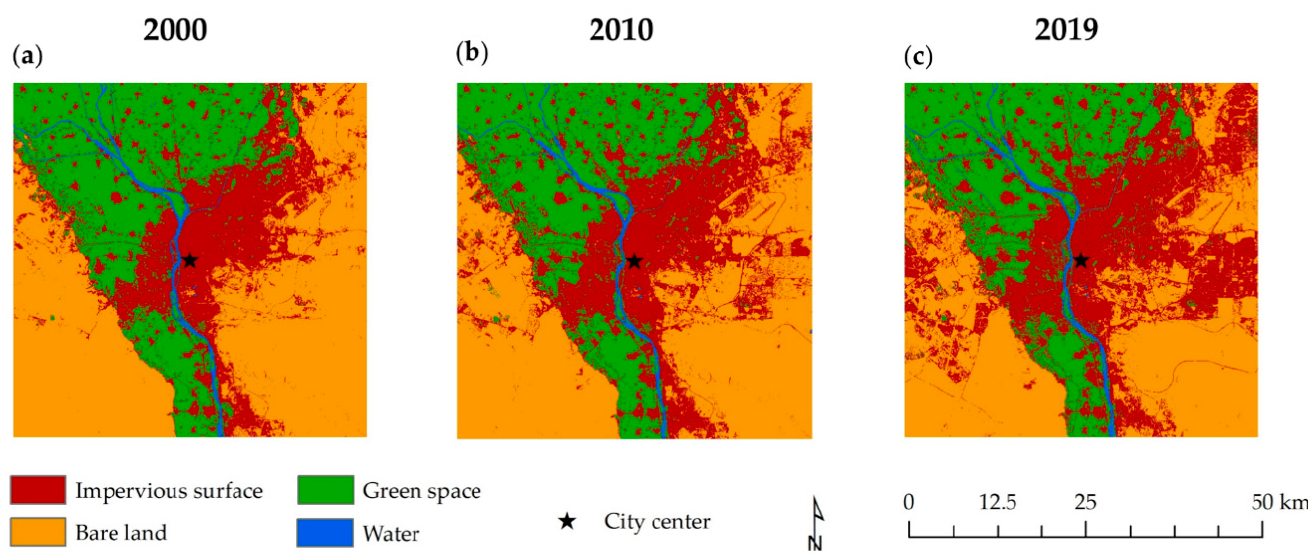
Figure 2. LUC patterns of Greater Cairo derived from Landsat imagery from GEE (from 2000 to 2019) and K-nearest neighbor classification by R software: ( a ) LUC map in 2000; ( b ) LUC map in 2010; and ( c ) LUC map in 2019. Table 2. Area change in the LUC in the study area.